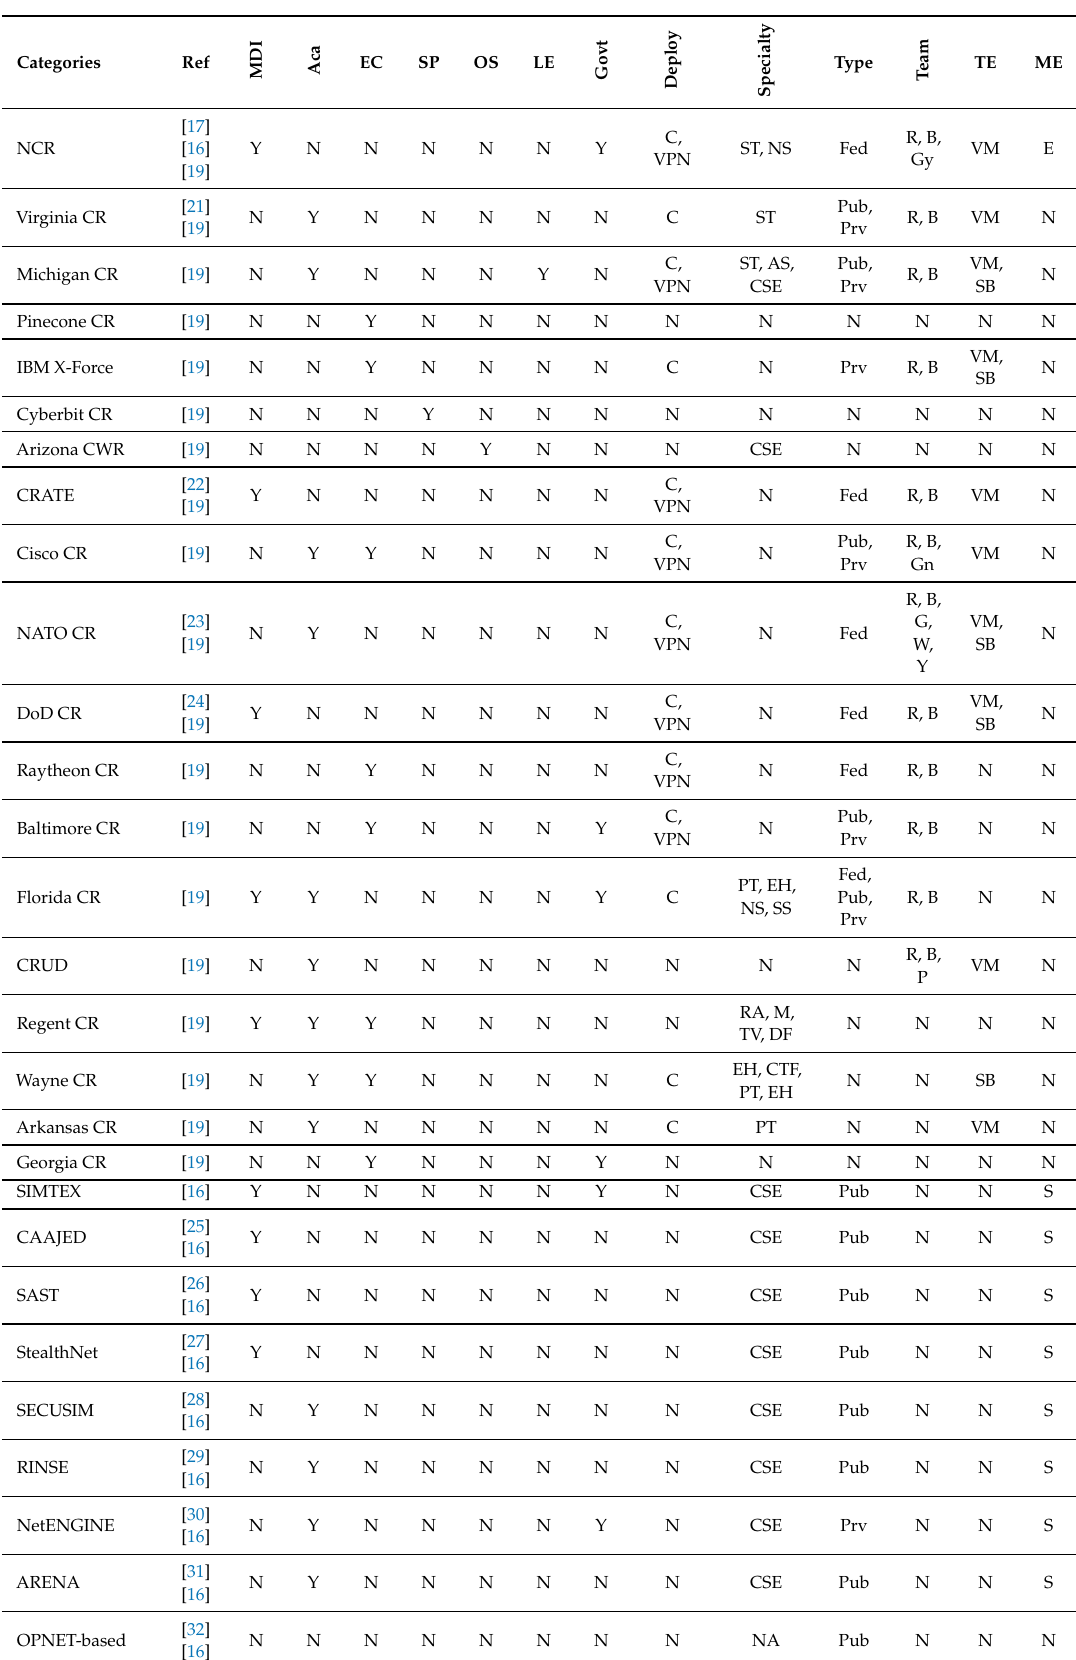
Table 1. Summary Table of Related